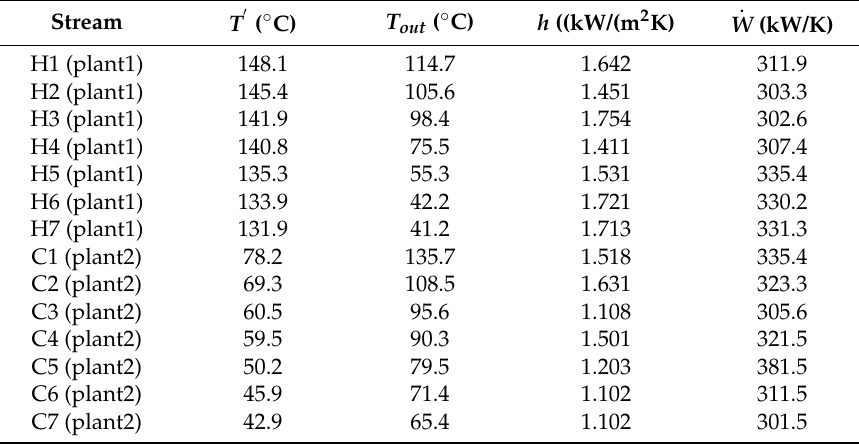
Table 4. Problem data for example